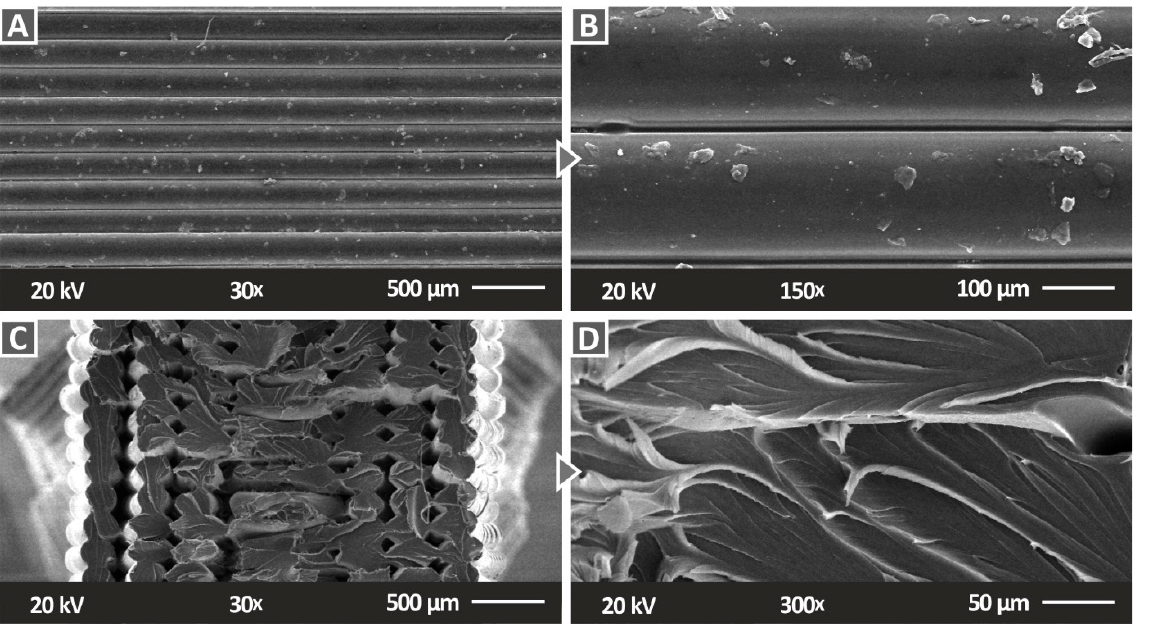
Figure 9. SEM micrographs of the 3D ‐ printed sample of pure PC polymer: ( A ) 30× magnification of the side surface, ( B ) 150× magnification of the side surface, ( C ) 30× magnification of the fracture surface, and ( D ) 300× magnification of the fracture surface.